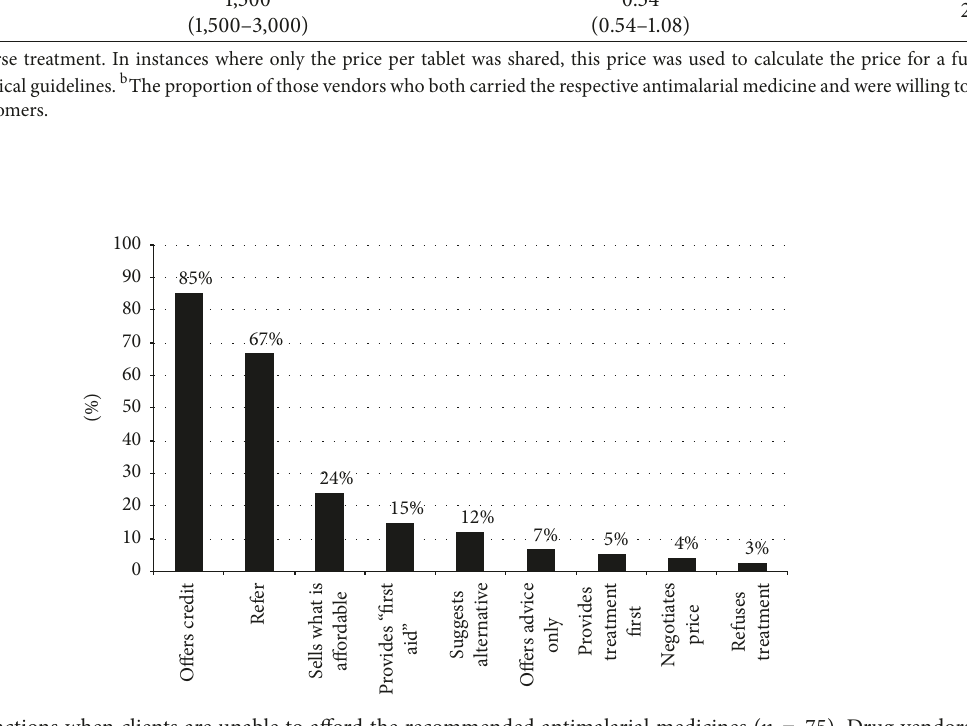
Figure 6: Vendors’ actions when clients are unable to afford the recommended antimalarial medicines ( 𝑛 = 75 ). Drug vendors provided multiple